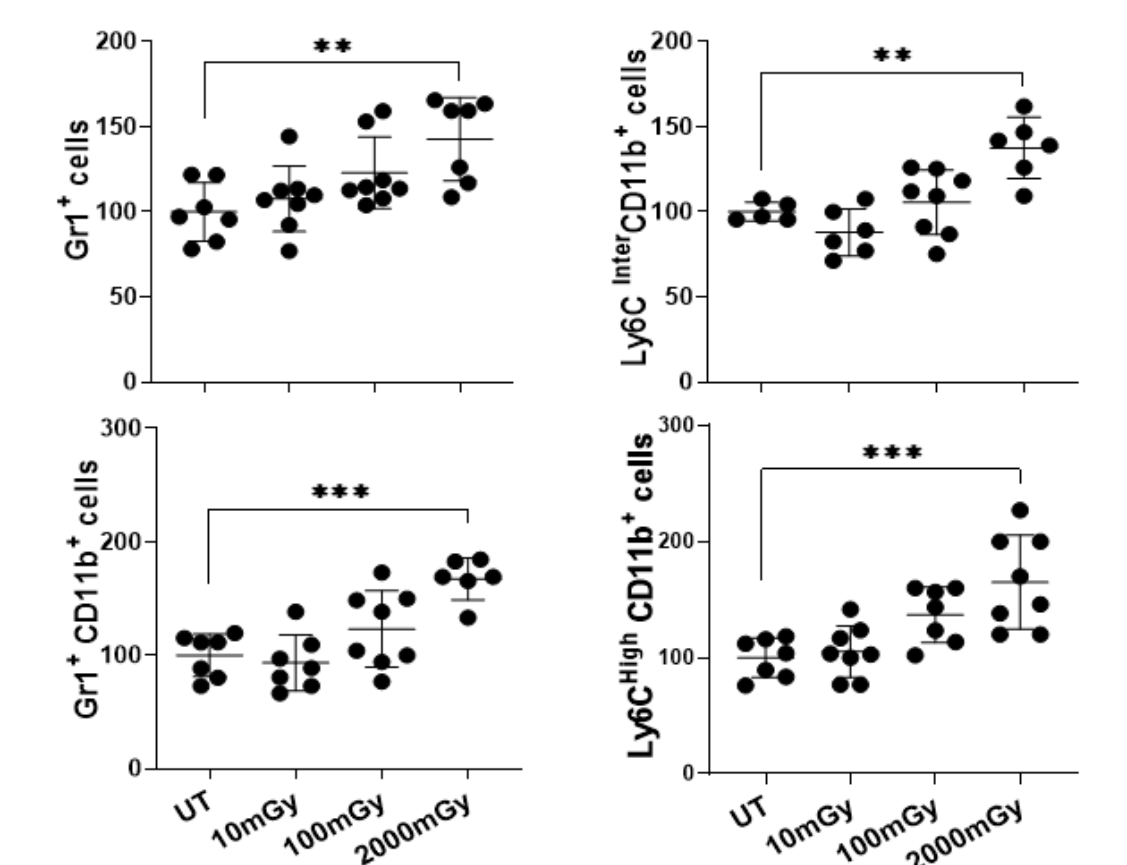
Figure 4. High-dose radiation promotes inflammatory conditions in vivo. Single-cell suspension of splenic lymphocytes was stained with various surface markers to identify, using flow cytometry, the proportion of inflammatory cell populations in mice sacrificed at 3.5 months of age and following LDR exposure. Y-axis represents the percentage of cells relative to the total population of mononuclear cells. Percent cells in untreated mice were set to 100%. Data represent mean + SD. ** p < 0.01, *** p < 0.001.